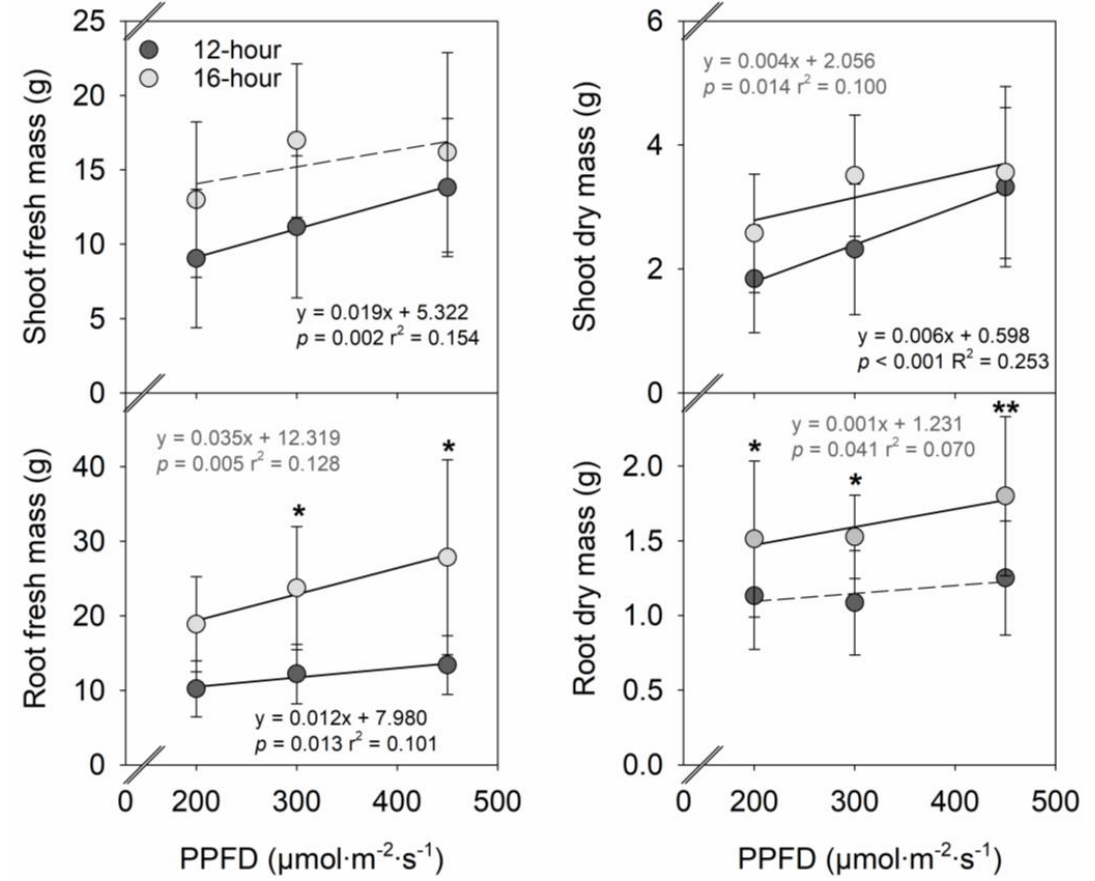
Figure 2. Influences of photosynthetic photon flux density (PPFD) of sole-source lighting treat- ments on fresh and dry mass of shoot and root of strawberry ‘Albion’ grown under a 12-h or 16-h photoperiod. Each data point represents the mean and standard deviation of two replications with 10 subsamples (plants) per replication (n = 20). Regression equations, coefficient of determination (r 2 ), and p values are presented when the linear relationship with PPFD is statistically significant at p < 0.05 (solid line), but not when insignificant (dashed line). At any PPFD, * or ** indicates means at a 12-h and 16-h photoperiod are significantly different at p < 0.05 or 0.01, respectively.